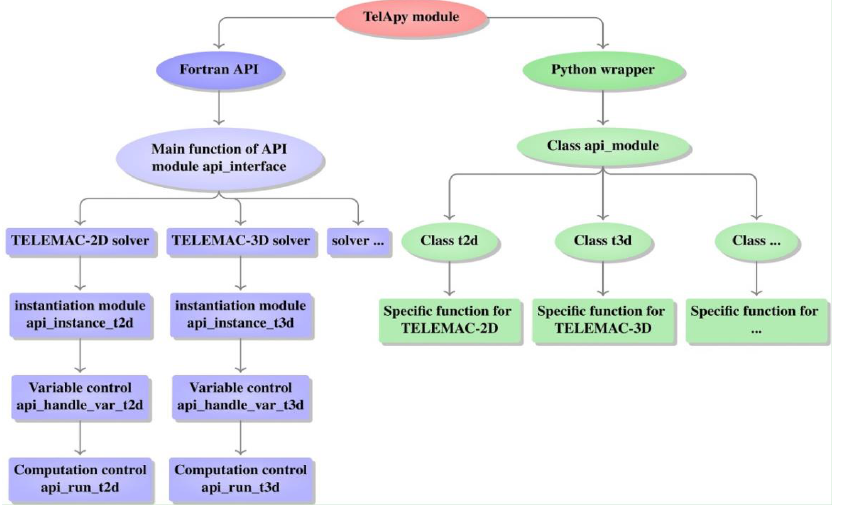
Figure 2. Overview of the TELAPY module [29].